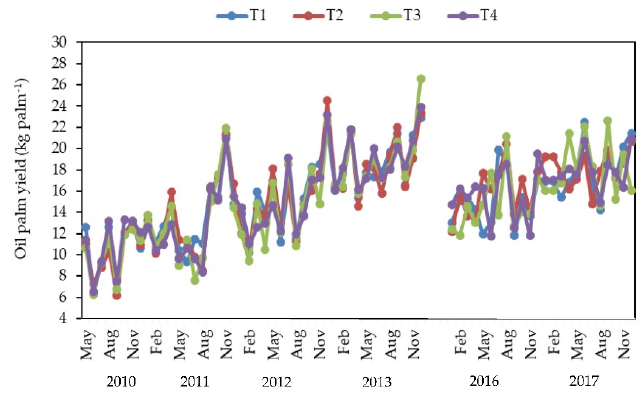
Figure 3. Oil palm yield for each treatment (2010–2017).